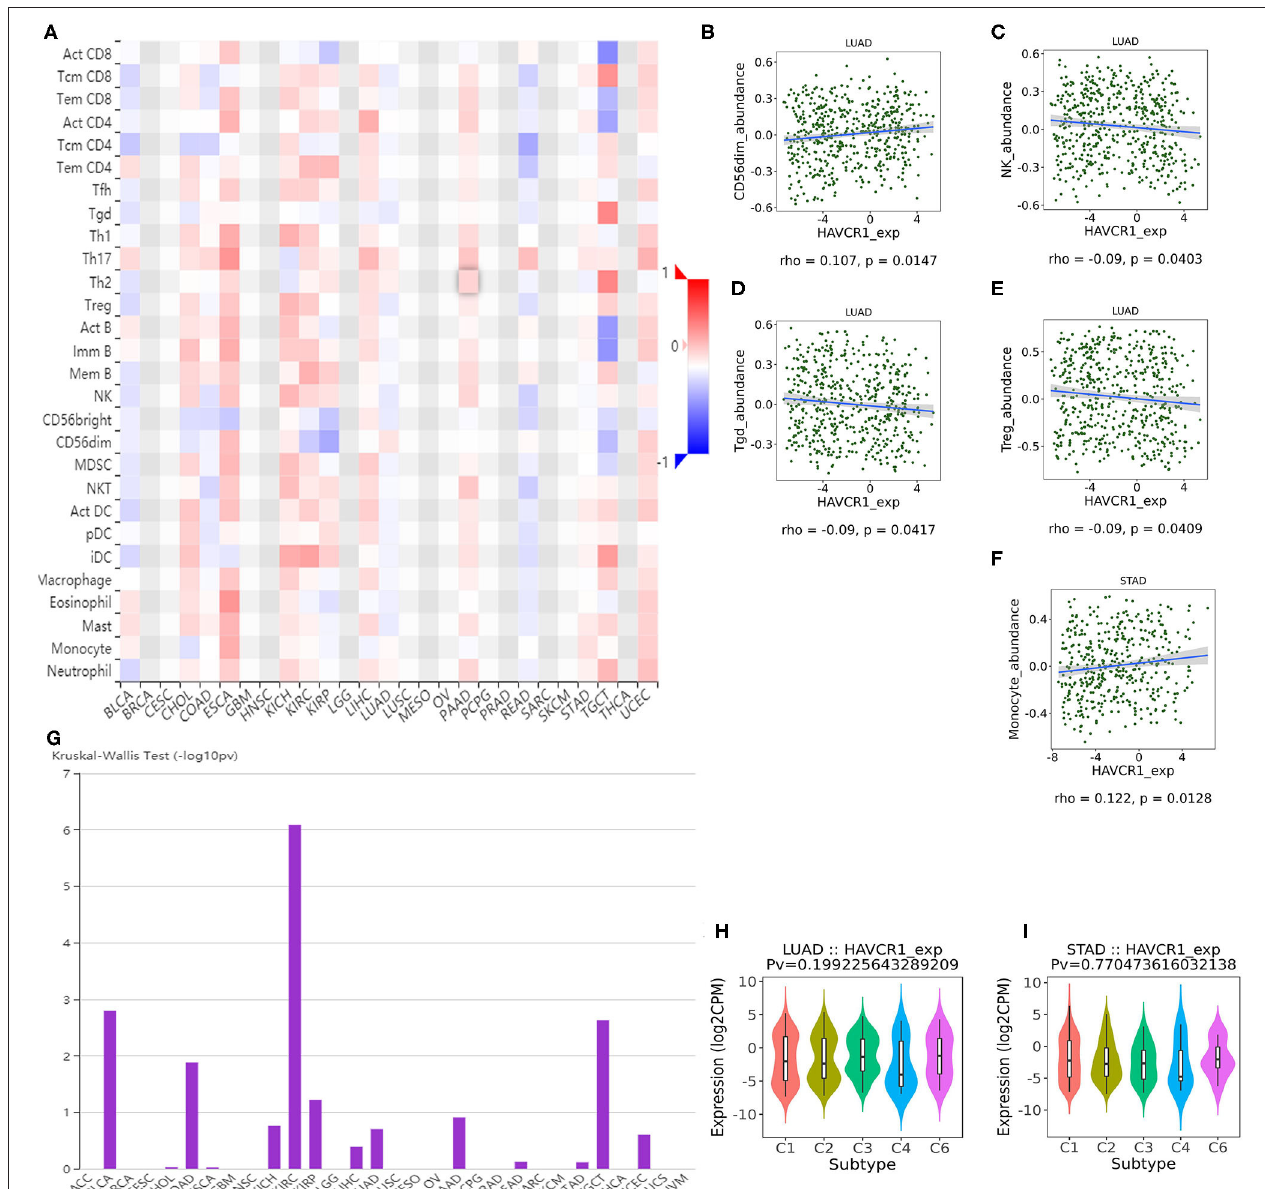
FIGURE 5 | Correlation of TIM-1 expression with immune infiltration level in cancer. (A) The landscape of relationship between TIM-1 expression and TILs in different types of cancer (red is positive correlated and blue is negative correlated). (B–F) TIM-1 expression was positively closely related with infiltrating levels of CD56dim natural killer cell in lung adenocarcinoma and monocyte in stomach cancer, and was negatively correlated with infiltrating levels of natural killer cell, gamma delta T cell, and regulatory T cell in lung adenocarcinoma. (G) The landscape of relationship between TIM-1 expression and immune subtypes across human cancers. (H,I) Correlation of TIM-1 expression and immune subtypes (wound healing, IFN-gamma dominant, inflammatory, lymphocyte depleted, TGF- β dominant) in stomach cancer and lung adenocarcinoma.